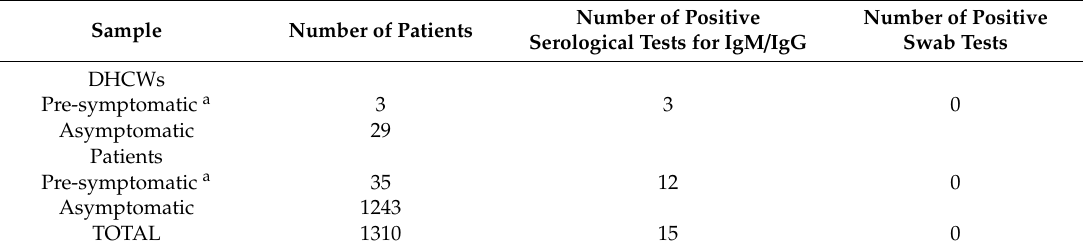
Table 1. DHCWs (Dental Health Care Workers) and patients attending dental clinic for consultation stratified for SARS-CoV-2 detection